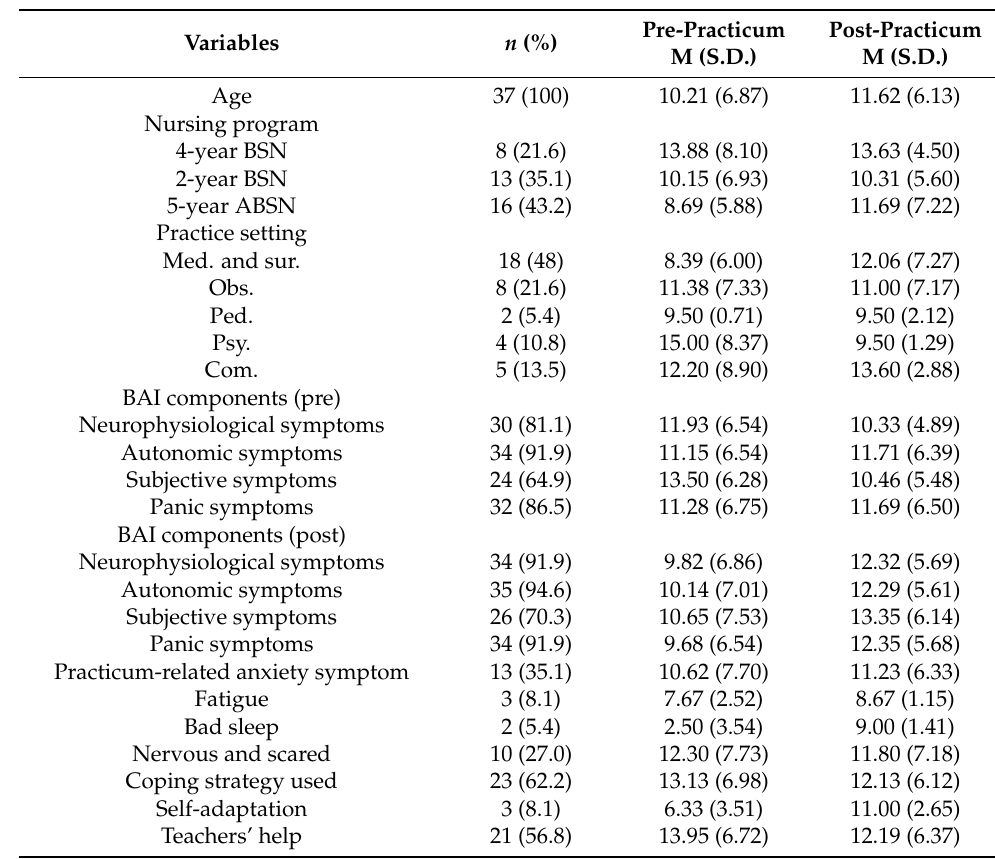
Table 1. Demographic distribution of